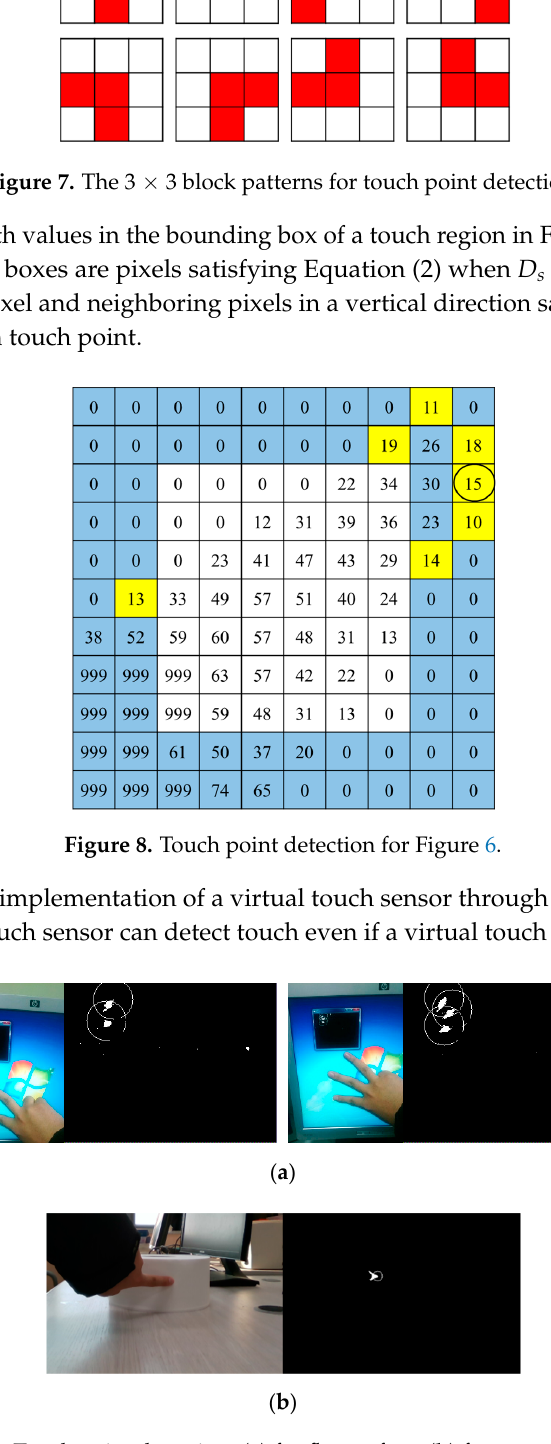
Figure 9. Touch point detection: ( a ) for flat surface; ( b ) for curved surface.